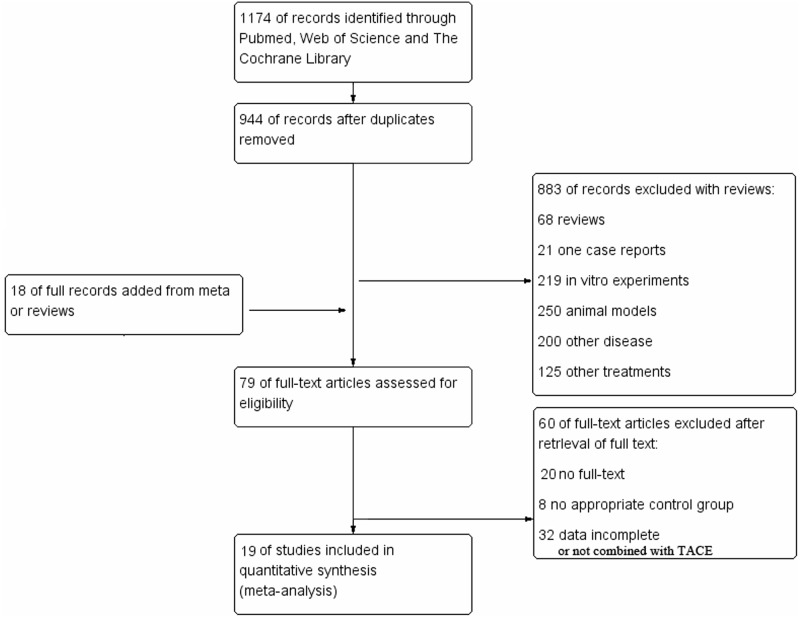
Flow chart of the included studies.